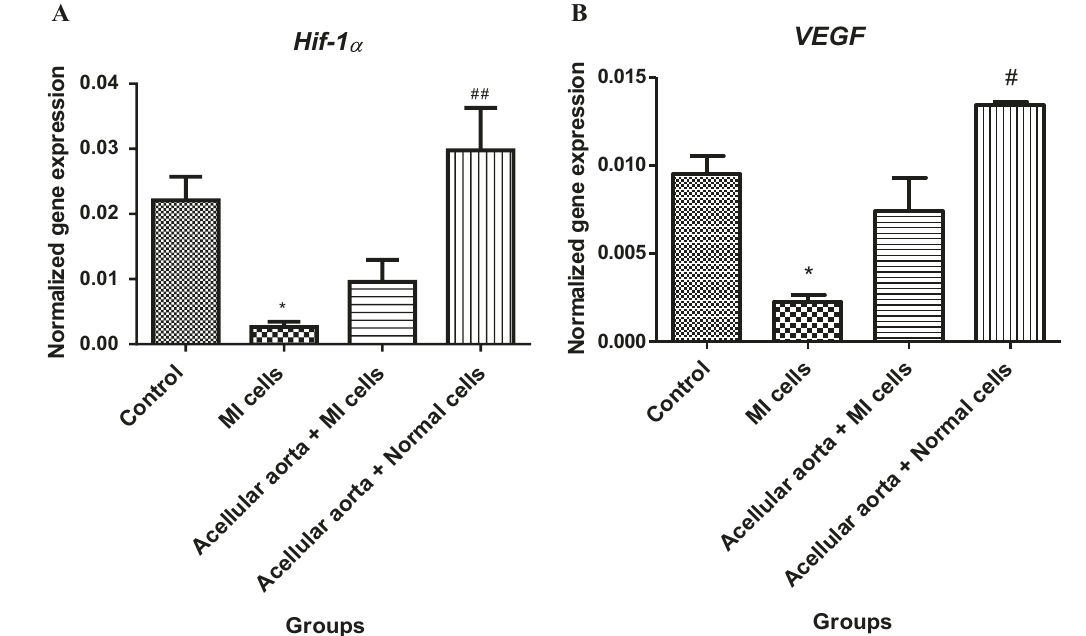
Fig. 3 The evaluation of alterations in genes expression levels of Hif- 1 α ( A ) and VEGF ( B ) as antigenic factors. The quantitative data showed that the expression levels of Hif-1 α and VEGF genes were severely dropped in the MI group. The acellular aorta matrix led to a remarkable increase in Hif-1 α and VEGF expressions compared to the